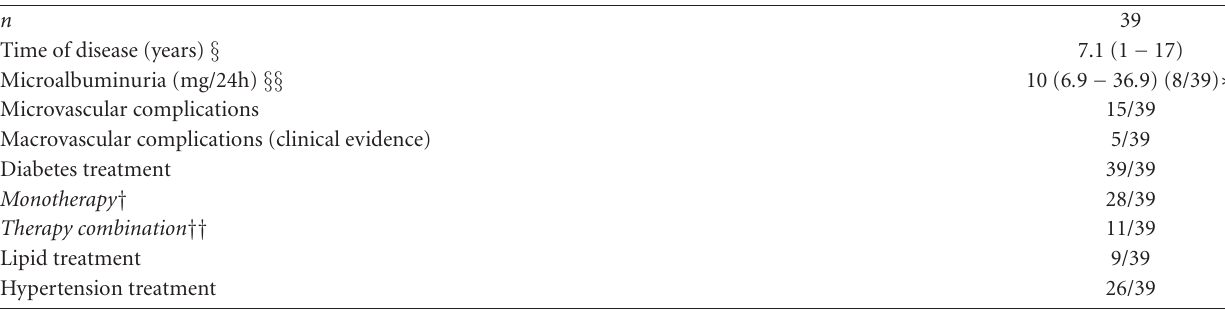
Table 2: Baseline clinical characteristics of studied diabetic patients. n = number of subjects, § = mean and range, §§ = median (with the 25th and 75th centiles-quartiles), ∗ = number of cases. † = treated with metformin, sulphonylurea, or insulin. †† = treated with two or more agents.